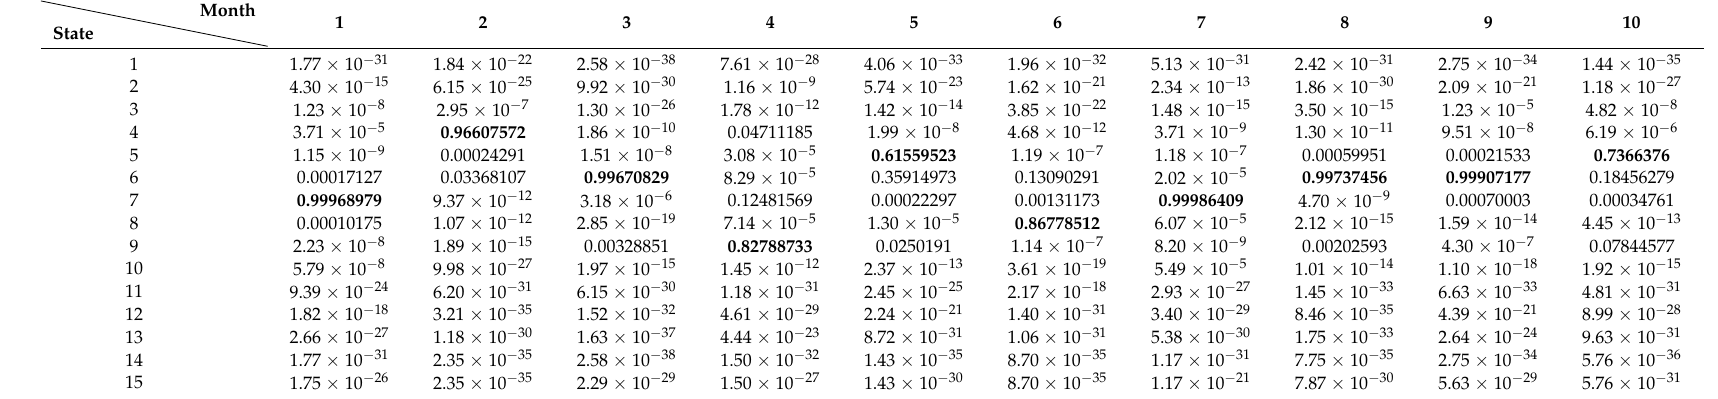
Table A2. Monthly predicted probability distribution of d 1 (The maximum probability of probability distribution for each month is highlighted).